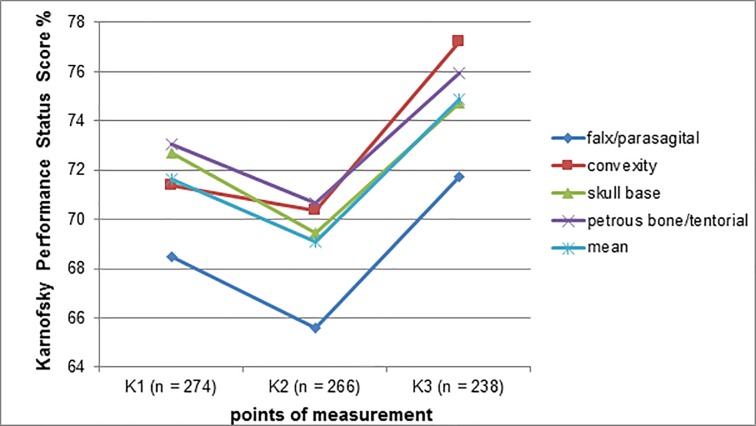
Karnofsky performance score at three points of measurement in relation to tumor origins (falx/parasagital vs. convexity vs. skull base vs. petrous/tentorial vs. average), K1 = preoperative; K2 = 3–6 months postoperative; K3 = 1 year postoperative; Kd = difference between K3 and K1.